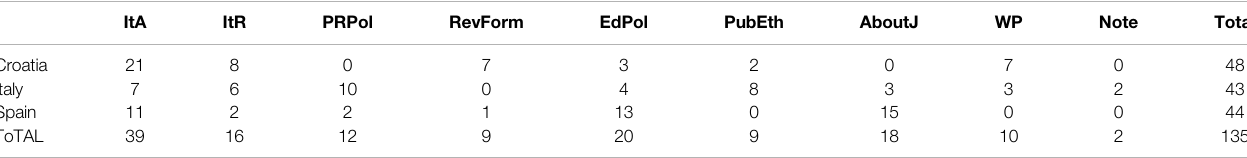
TABLE 2 | Documents included in content analysis by type.